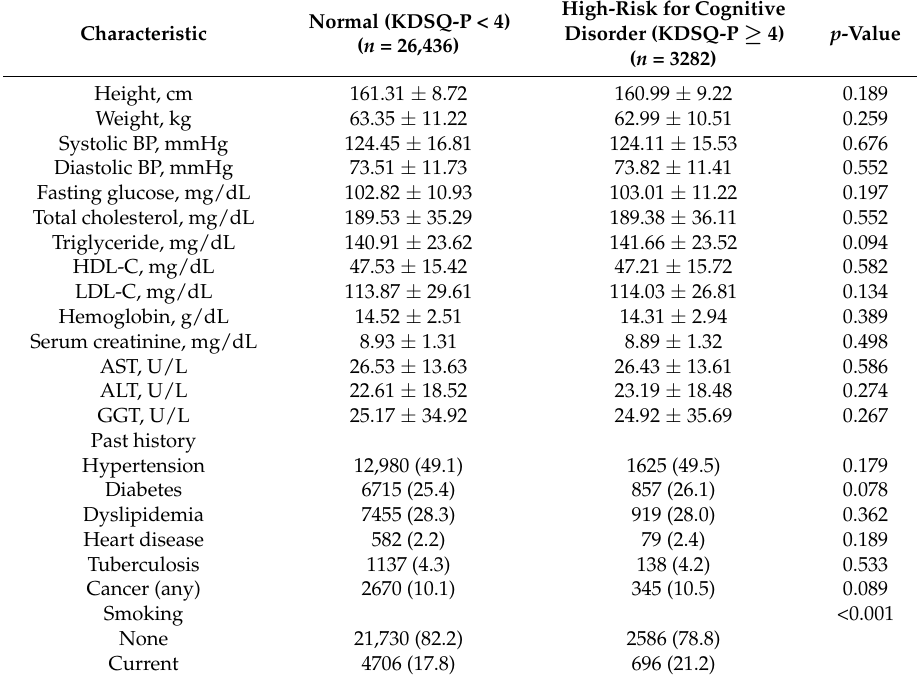
Table 1. Clinical characteristics of subjects according to primary screening tests for cognitive